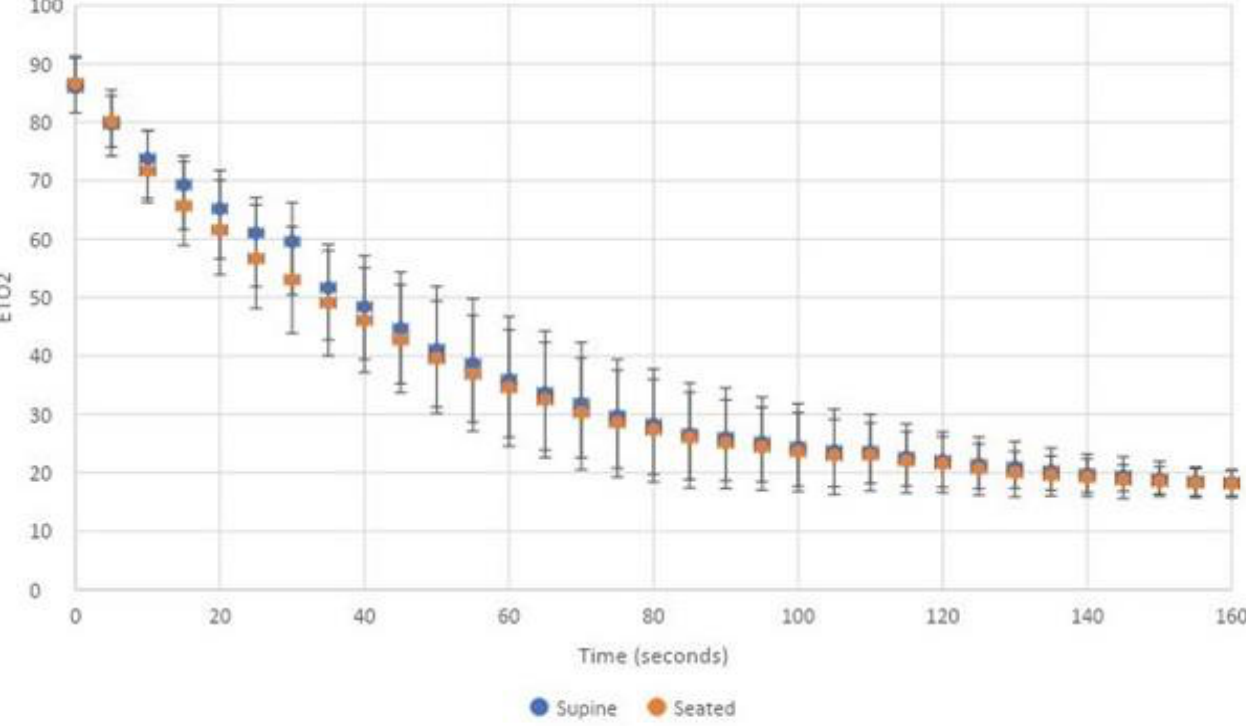
Figure. Renitrogenation after maximal preoxygenation in the supine and seated